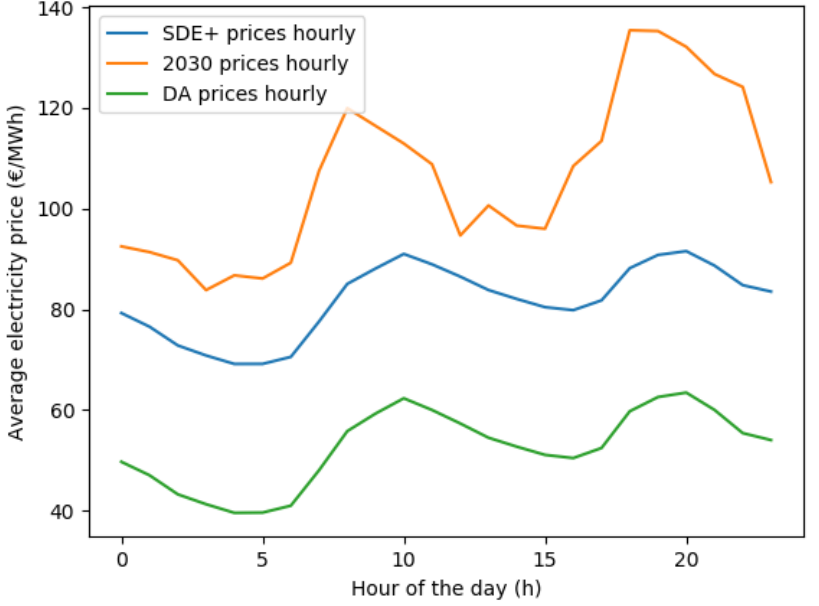
Figure 2. Profiles of average hourly price values used as input in the investigated price